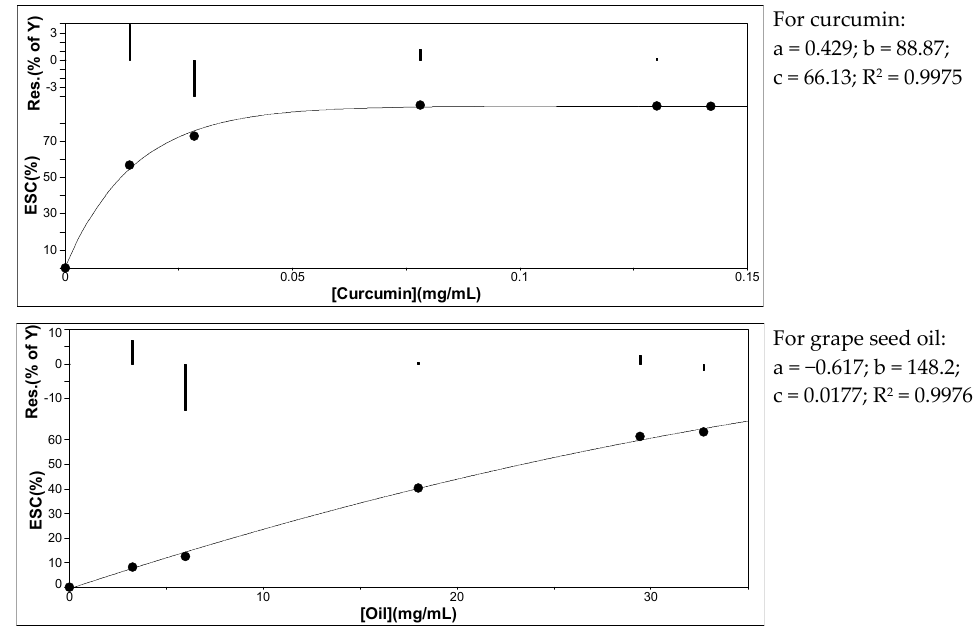
Figure 7. Variation of experimental scavenging activity toward DPPH with antioxidant concentration (solid lines represent the best fit of Equation (5) to experimental data).